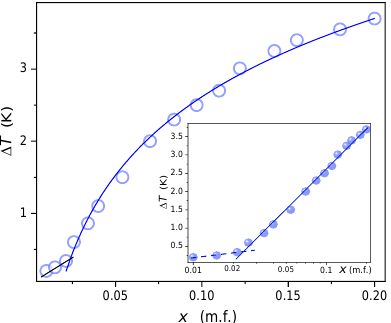
Figure 2. Changes of the temperature width of (I + N) for TP1 (low concentration of isooctane) biphasic region in MBBA + isooctane mixture; 𝑇 = 𝑇 𝑇𝑃1𝐼 − 𝑇 𝑁𝑇𝑃1 , x stands for isooctane concentration in mole fraction. The inset is related to the analysis via the logarithmic Equation (4): the resulting behavior is also shown by the blue curve in the main plot.